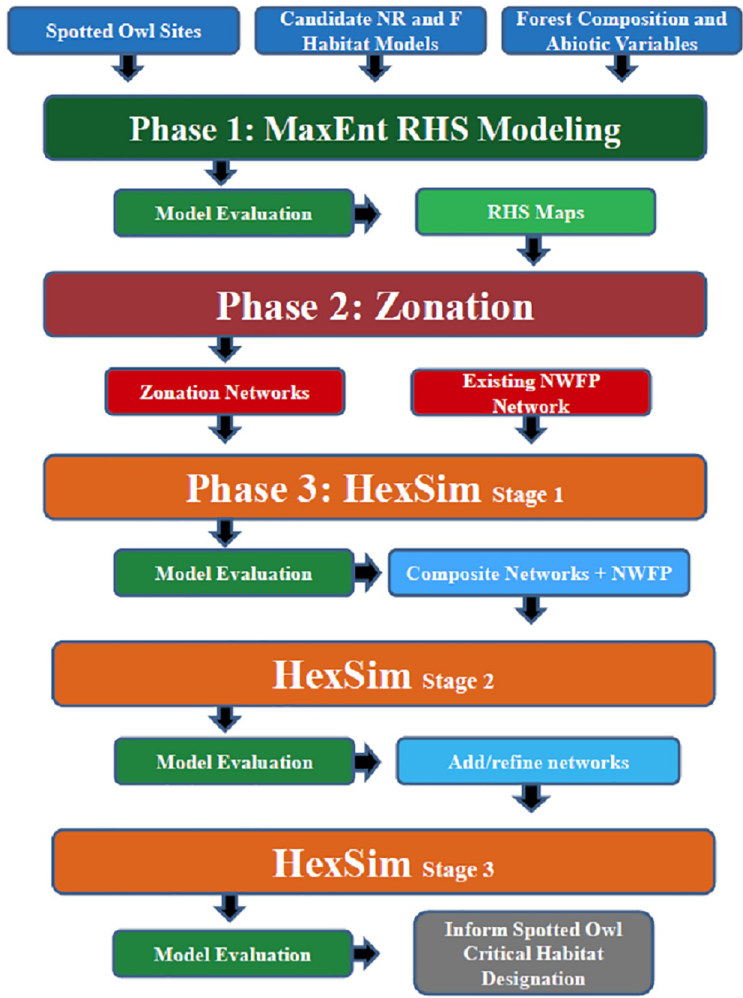
Fig 2. Flow chart of generalized modeling phases. NR = nesting and roosting, F = foraging, RHS = relative habitat suitability, NWFP = Northwest Forest Plan.